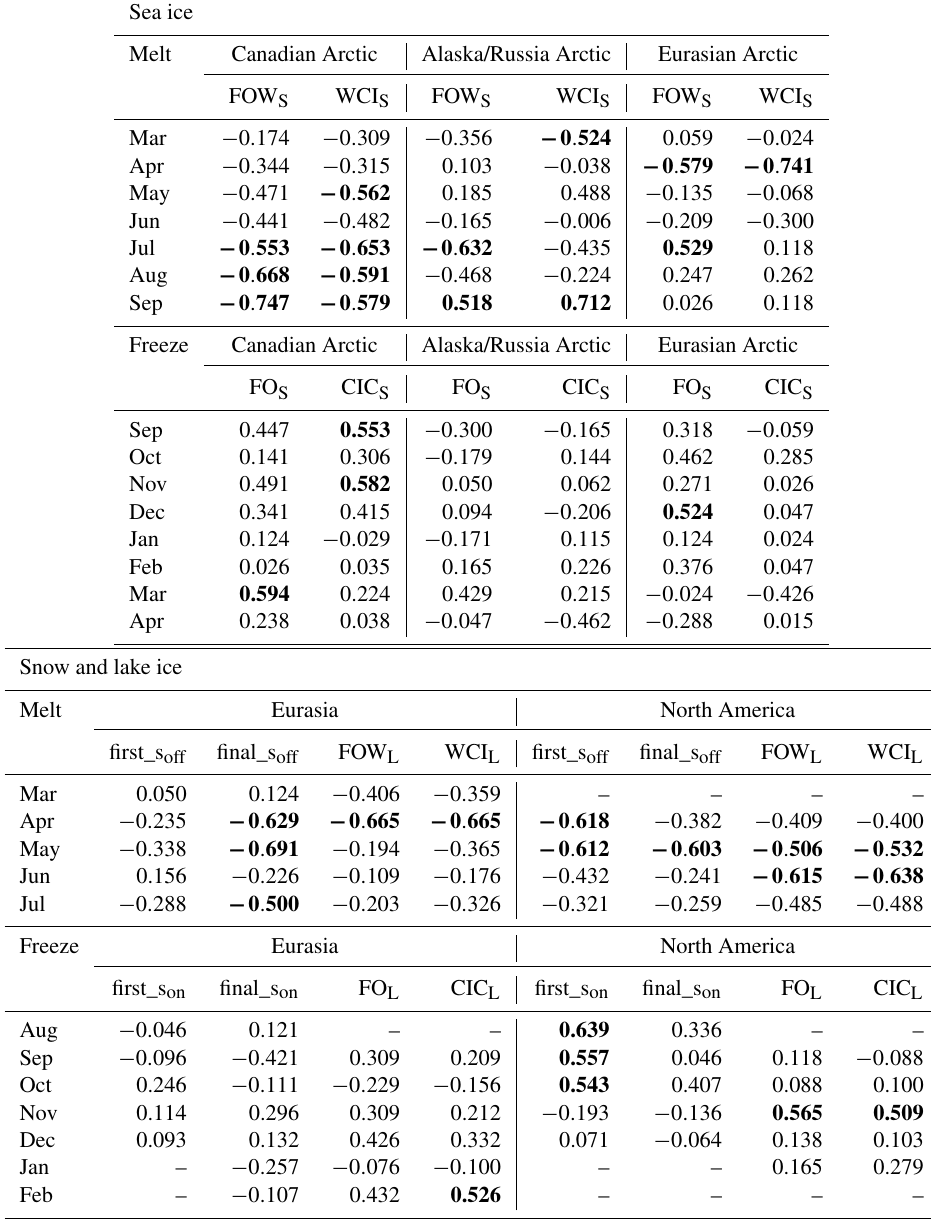
Table 4. Regional Spearman rank correlations ( ρ ) for snow and ice phenology dates and monthly 2m temperature from 2004–2019 using 4km IMS. For sea ice, Canadian Arctic includes Baffin Bay, Hudson Bay, and the CAA; Alaska/Far East Russia includes the Beaufort, Chukchi, and Bering seas; and Eurasian Arctic includes the East Siberian, Laptev, Kara, Bering, and Greenland seas (see Fig. 1). Months were selected for each phenology parameter based on mean phenology dates in Fig. 3. Bold represents statistically significant correlations at the 95% confidence